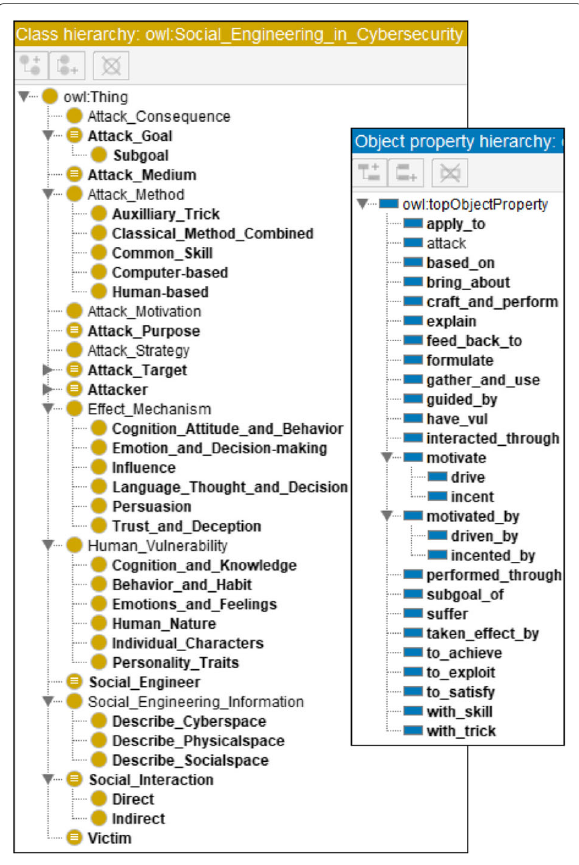
Fig. 14 Overview of concepts and relations defined in Protégé